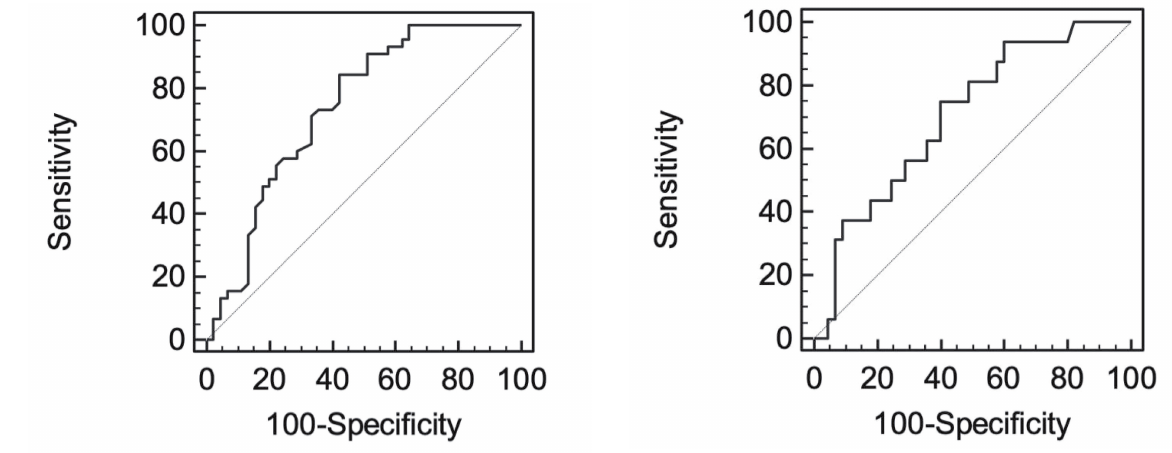
Figure 1 - Receiver operating curve used to define optimal cut off value of NLR for localized TGCT.